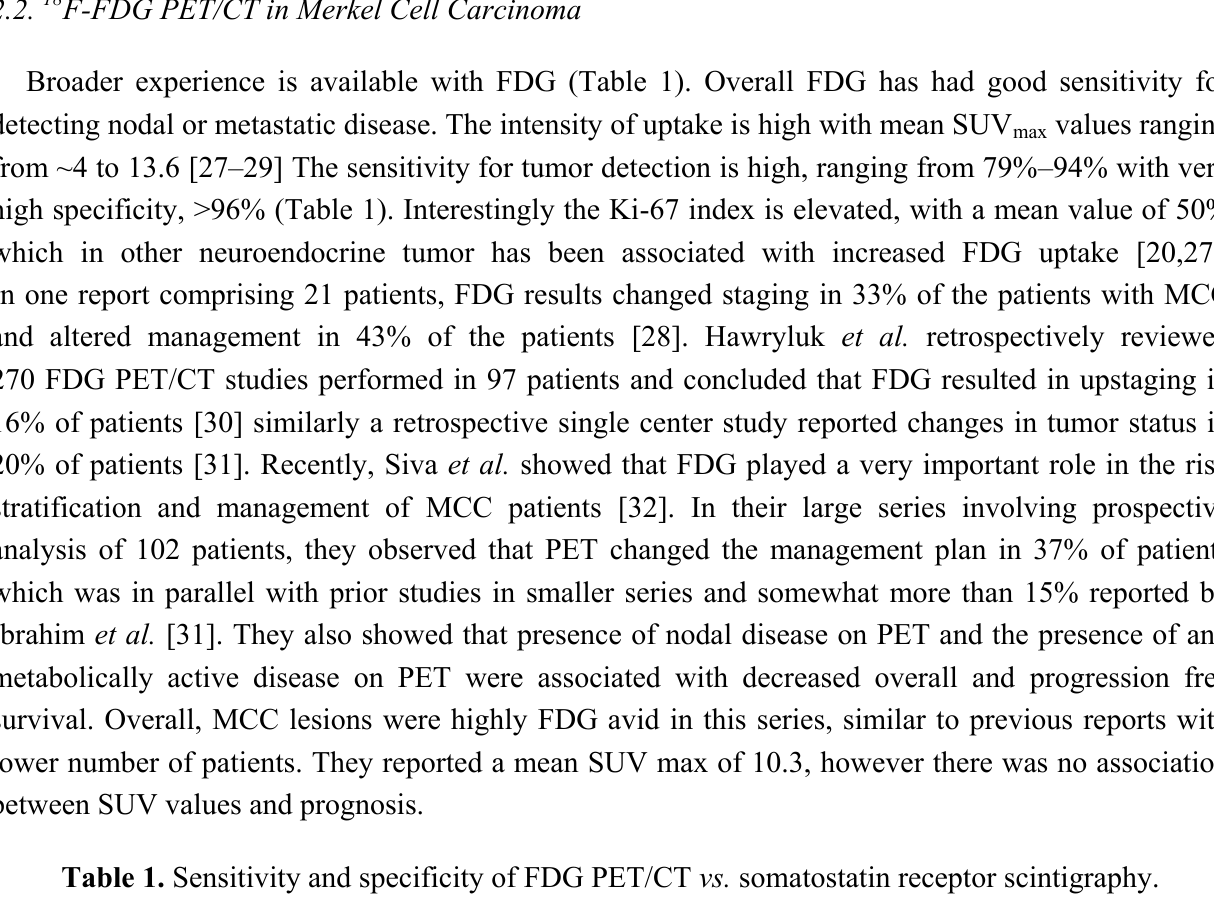
Table 1. Sensitivity and specificity of FDG PET/CT vs. somatostatin receptor scintigraphy. Author (number of